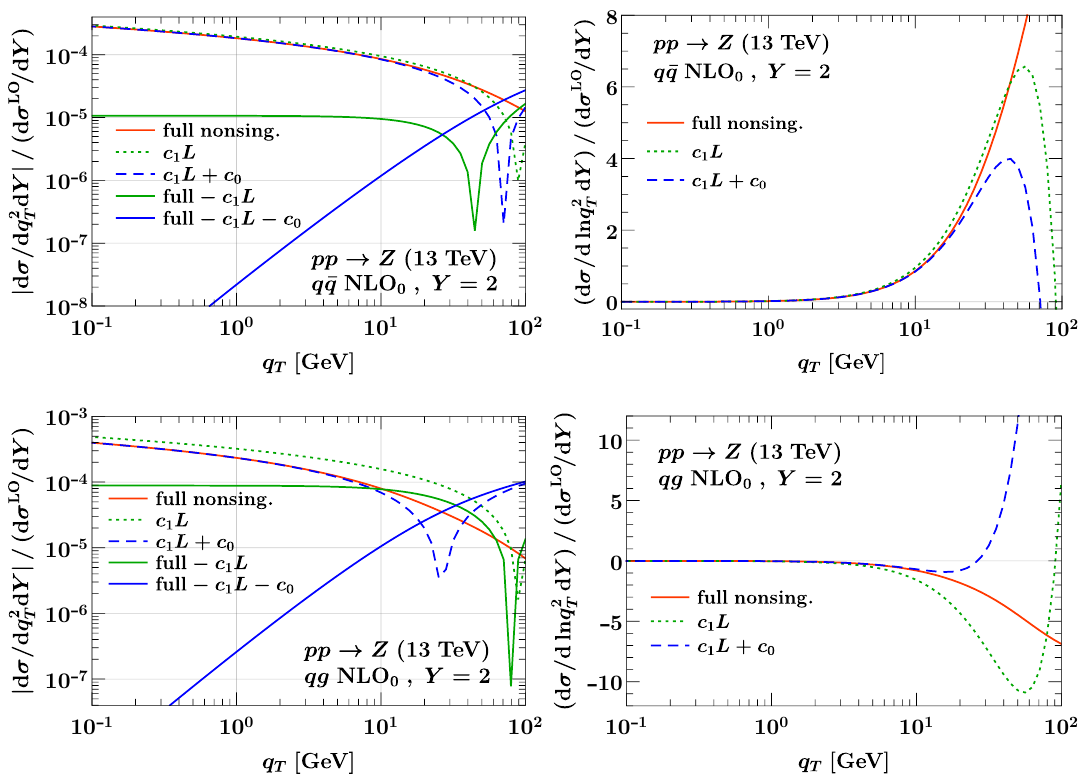
Figure 2 . Comparison of the LL and NLL corrections at subleading power with the full nonsingular q T spectrum for all partonic channels contributing to Drell-Yan production at NLO 0